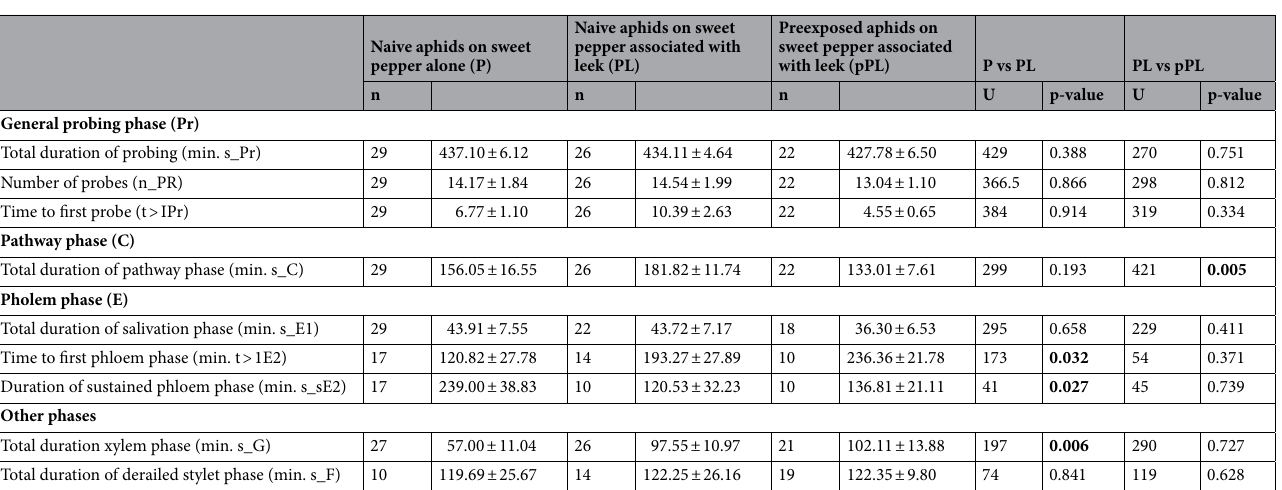
Table 1. Feeding behavior parameters (mean + /- SEM) of M. persicae on sweet pepper depending on the plant status (sweet pepper associated or not with leek) and on the aphid status (pre-exposed or not to leek VOCs). Behavior of naive M. persicae on sweet pepper alone (P) was compared to that of naive M. persicae on sweet pepper associated with leek (PL) and then behavior of naive M. persicae on sweet pepper associated with leek (PL) was compared to that of pre-exposed M. persicae to leek VOCs on sweet pepper associated with leek (pPL). P values < 0.05 (Mann–Whitney U-test) are written in bold; n: sample